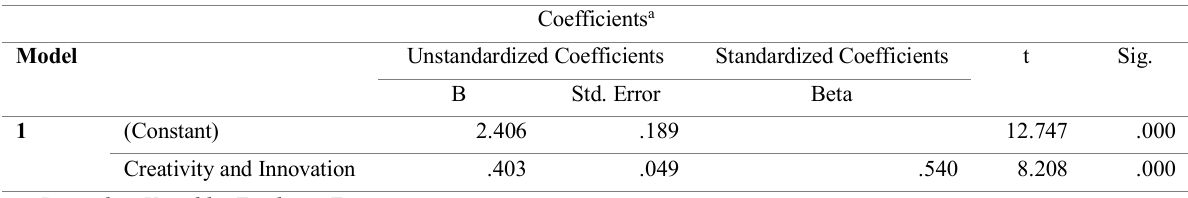
Table 2 (c): Regression Coefficients for Creativity and Innovation and Employee Engagement